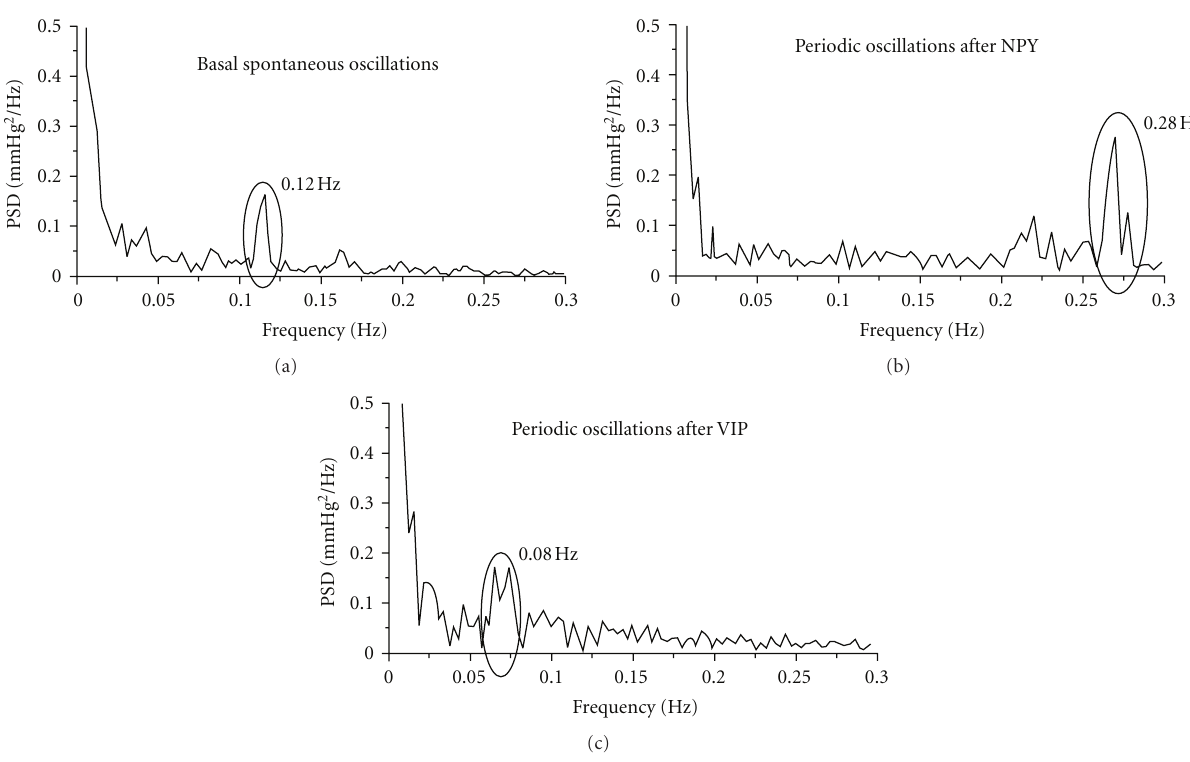
Figure 3: In the upper panel, the power spectrum density (PSD) of basal spontaneous oscillations obtained as a result of mathematical analysis with the Fast Fourier algorithm shows a major band at 0.12Hz. In the middle panel, the power spectrum density obtained after Fourier analysis of the oscillations after NPY injection shows a major band around 0.28Hz which results in an increase in the frequency of the oscillations, so there was a marked increase in the frequency of the spontaneous oscillations. In the lower panel, the power spectrum density obtained after VIP injection shows a peak frequency of 0.08Hz, so there was a decrease in the frequency of the spontaneous